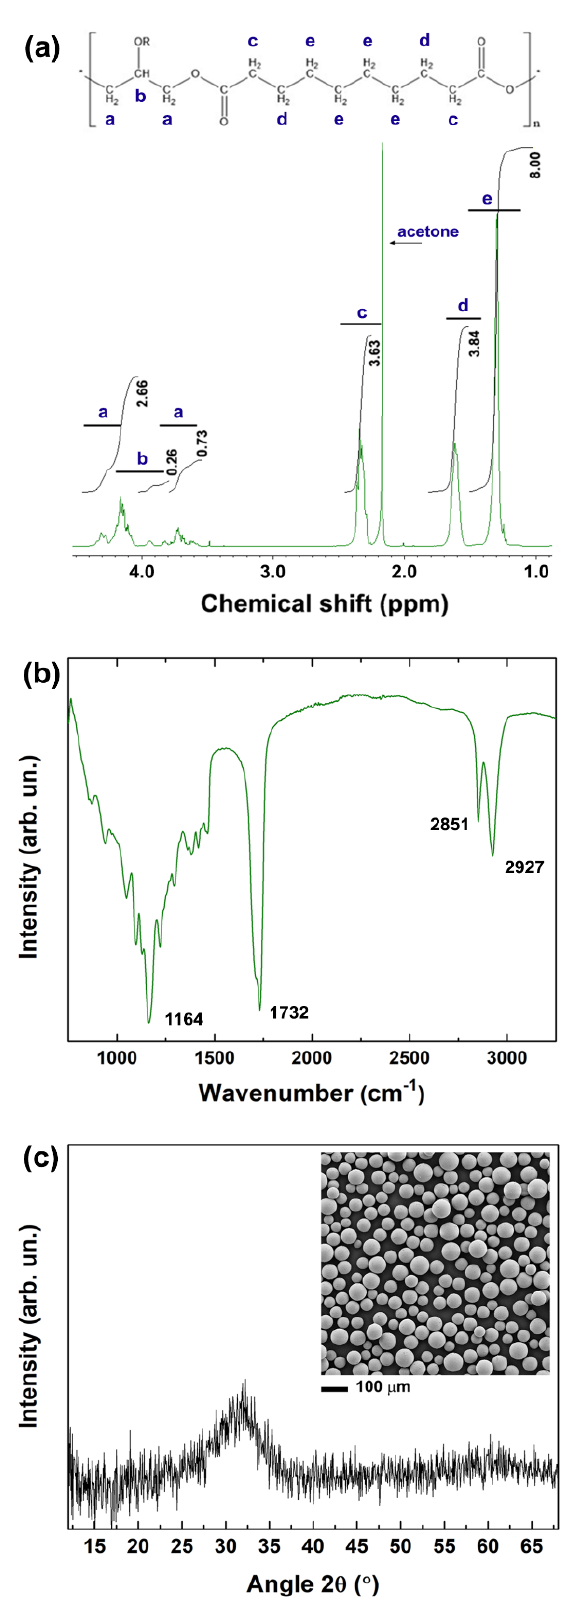
Figure 1. ( a ) 1H NMR spectrum of poly (glycerol sebacate) (PGS) in deuterated acetone. The typical chemical structure of PGS is shown at the top of the graph. ( b ) FTIR spectrum of PGS. The characteristic peaks are indicated in the graph. ( c ) XRD pattern of the 45S5 bioactive glass microspheres and their morphology analysed by SEM (inset).